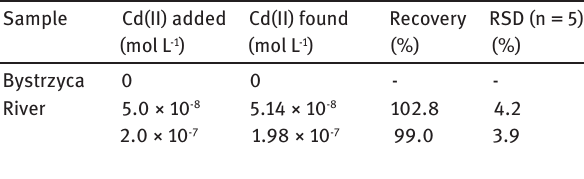
Figure 5: Calibration curve of Cd(II). The solution for electrode preparation contained 0.1 mol L -1 acetate buffer pH = 4.6 ± 0.1, 2 × 10 -5 mol L -1 Pb(II), 1 × 10 -5 mol L -1 Zn(II) and increasing concentration of Cd(II). Zn, Pb and Cd were deposited at -1.6 V for 180 s. The potential